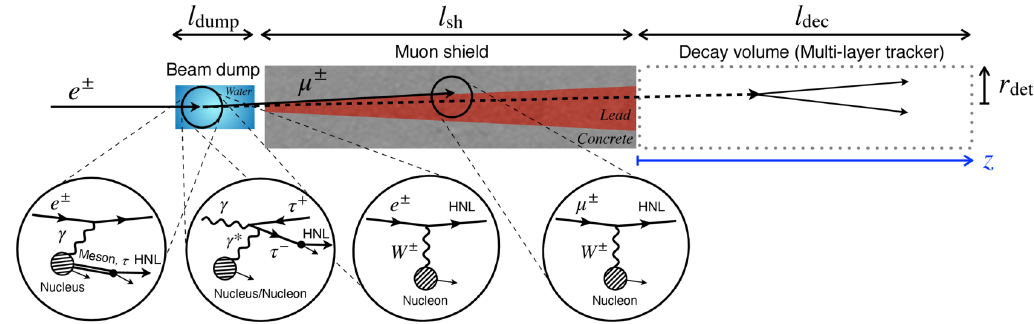
Figure 1 . A setup for ILC beam dump experiments. It consists of the main beam dump, a muon shield, and a decay volume. We assume a multi-layer tracker is placed in the decay volume so that the charged tracks are